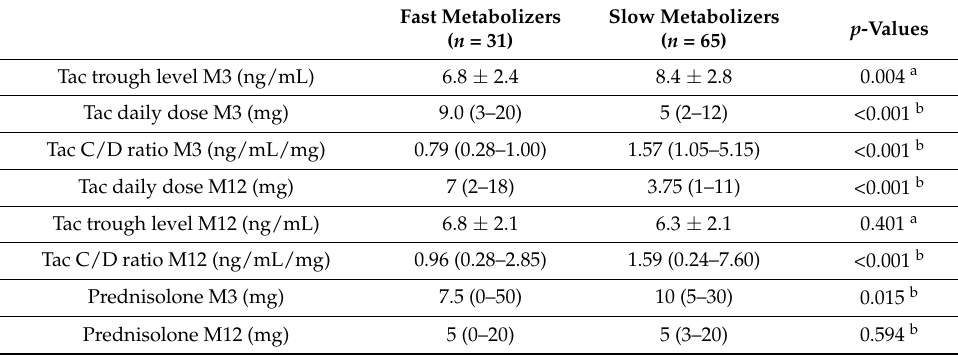
Table 2. Immunosuppression, statins, complications, cholesterol levels, and